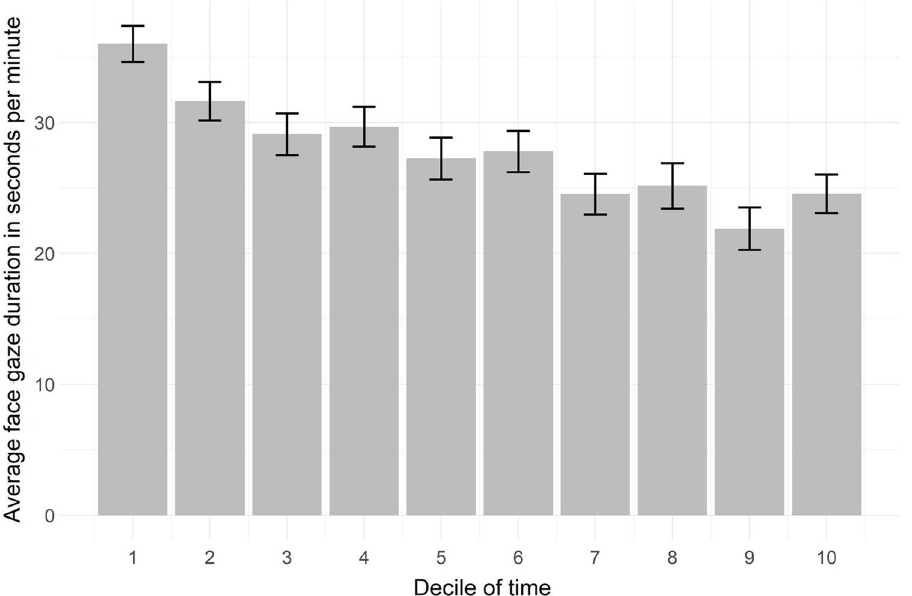
Figure 1. Development of the physicians’ face gaze duration per minute throughout the consultations per decile of